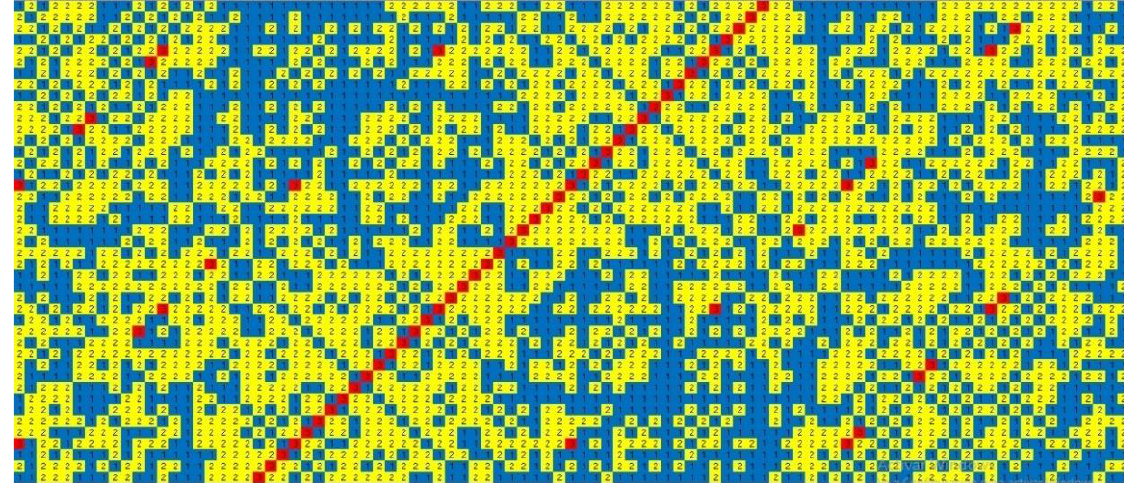
Figure 16. Detail of color map (or heatmap) fractal for the Borda method with n = 4.